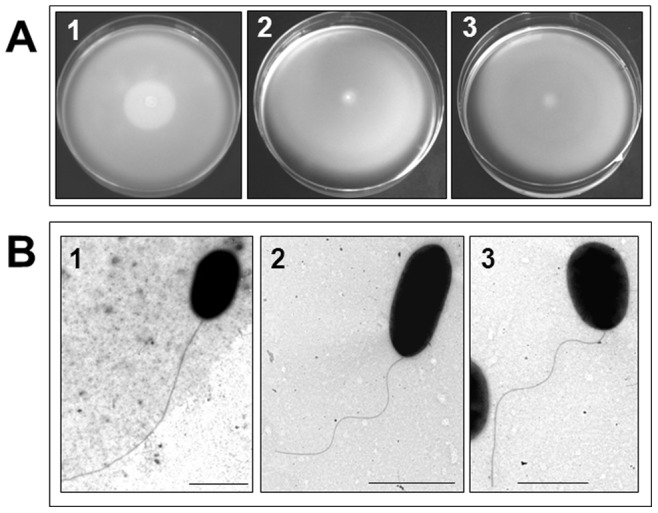
A/Motility phenotypes exhibited in swim (0.25%) agar.B/Electron microscopy of whole cells from A. hydrophila strains stained according to Experimental Procedures. Bar represents 1μ. 1, A. hydrophila AH-3 (wild type); 2, A. hydrophila O− mutant AH-3ΔManC; 3, A. hydrophila O− mutant AH-3ΔWaaL [22], [23].